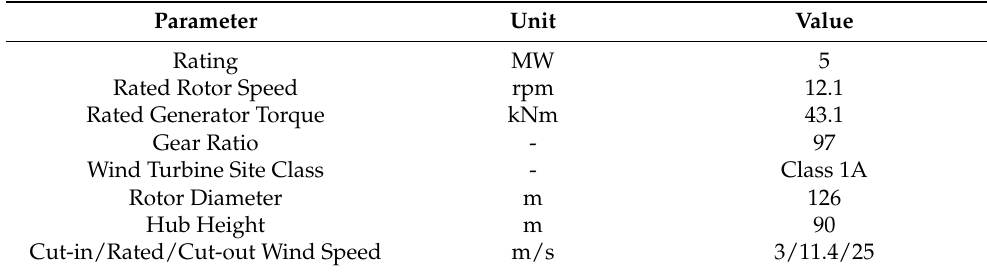
Figure 1. Model of NREL 5MW wind turbine. Table 1. Specifications of NREL 5MW wind turbines.